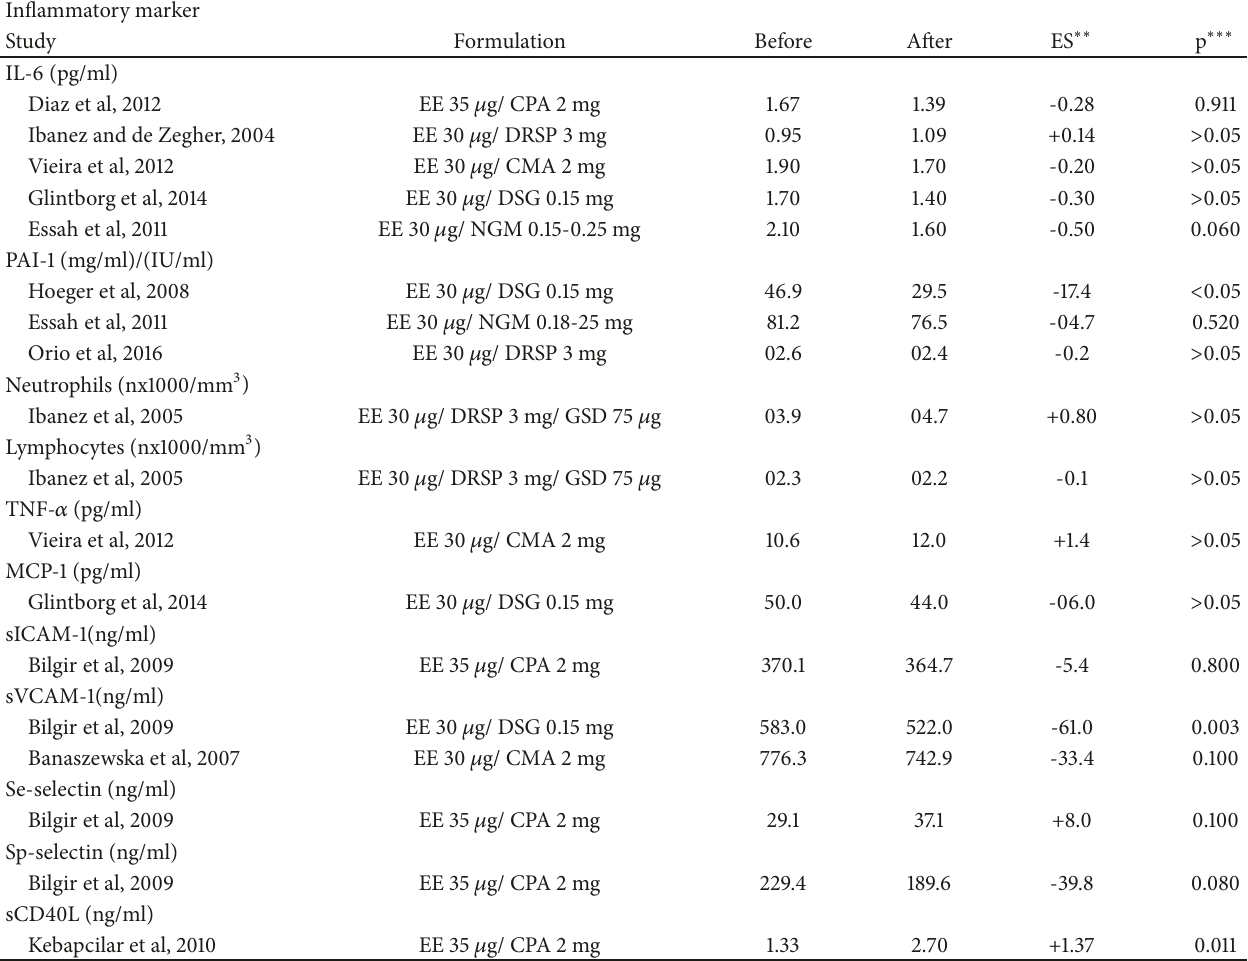
Table 4: Influence of different oral contraceptive combination on markers of chronic inflammation in polycystic ovary syndrome ∗ . Inflammatory